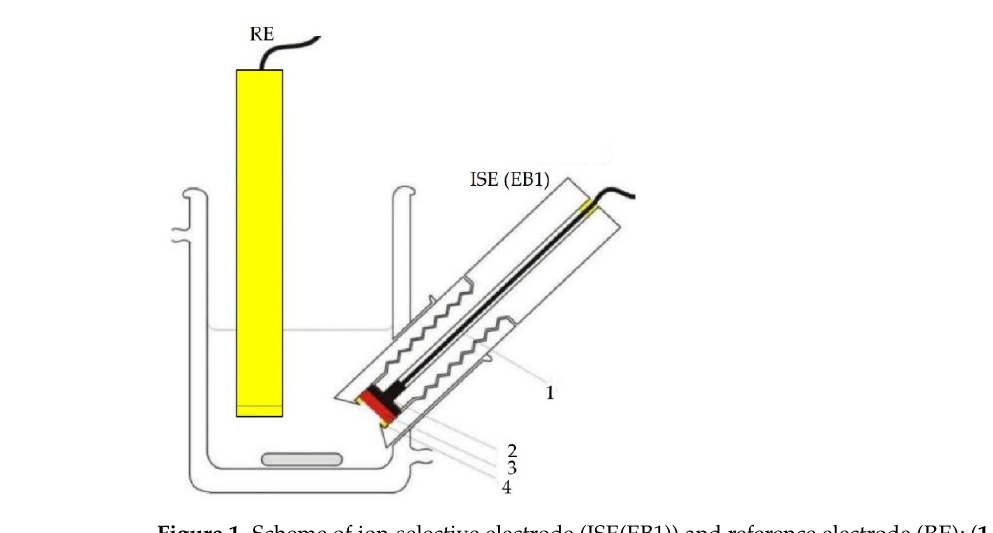
Figure 1. Scheme of ion-selective electrode (ISE(EB1)) and reference electrode (RE); ( 1 —coaxial cable, 2 —steel disc, 3 —membrane, 4 —silicon rubber) [27] .